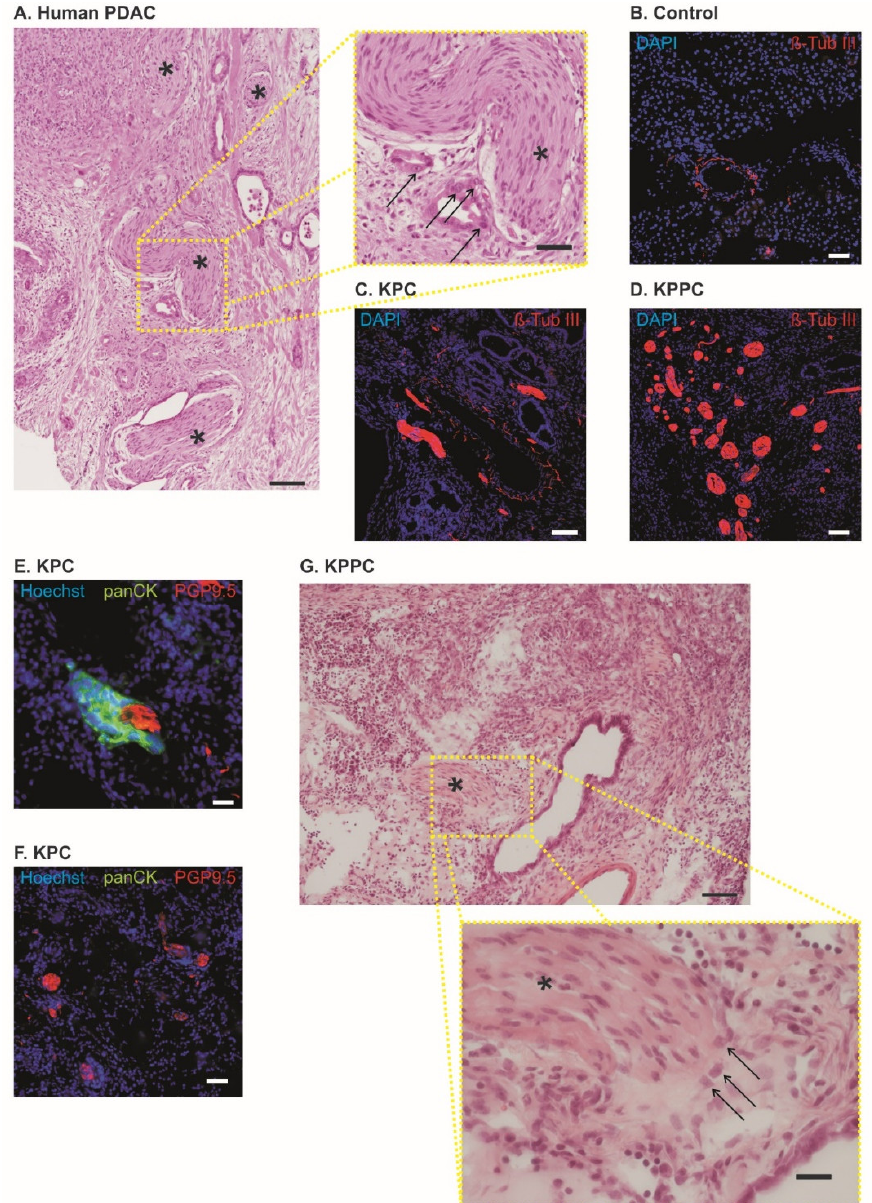
Figure 2. KPC mice and KPPC mice show nerve fiber hypertrophy and increased fiber density . ( A ). Human pancreatic cancer specimen with nerve fiber hypertrophy and increased nerve fiber density; Asterisk = Nerve; Arrow = PDAC (Scale bar = 100 µm in low magnification and 40 µm in high magnification). ( B – D ). Representative images of neuronal structures (Anti-beta-Tub III) in control ( B ), KPC mice ( B ) and KPPC mice (( D ); scale bar = 100 µm). ( E – F ). Co-stating of PGP 9.5 (neuronal marker) with panCK (marker for PDAC) in tissue from KPC mice. ( G ), H&E staining in KPPC tissue showing cancer cells (arrows) invading the neuronal compartment (asterisk). Scale bar: 100 µm in low magnification and 10 µm in high magnification.